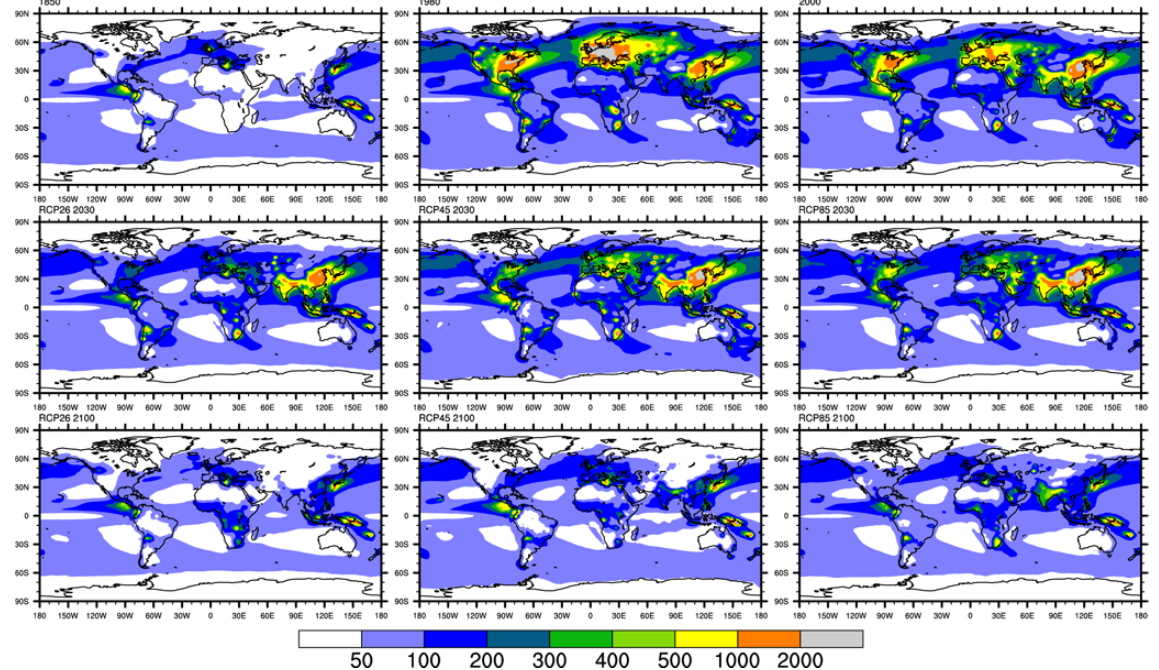
Fig. 5c. Total (wet + dry) SO x deposition 1850–2100(mg(S)m − 2 yr − 1 ). Top row shows 1850, 1980 and 2000. Middle row shows 2030 for RCP2.6, RCP4.5 and RCP8.5. Bottom row shows 2100 for RCP2.6, RCP4.5 and RCP8.5.